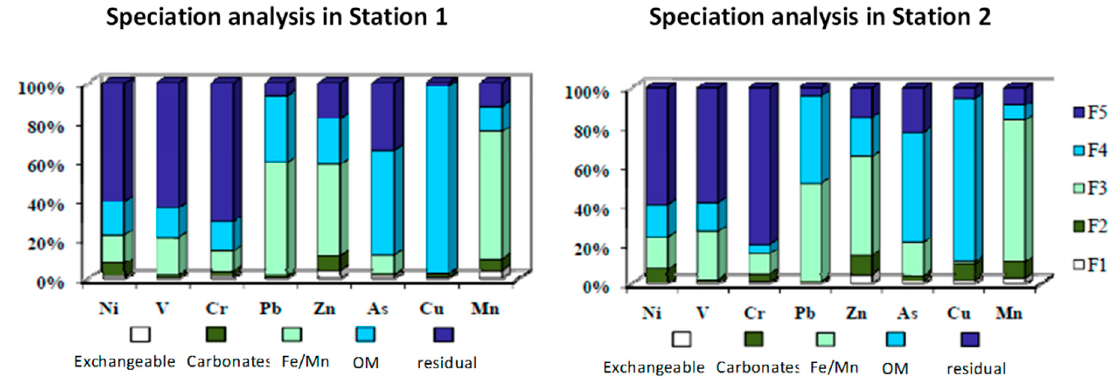
Figure 14. Results of the speciation analyses in Stations 1 and 2 (by using the Tessier approach).